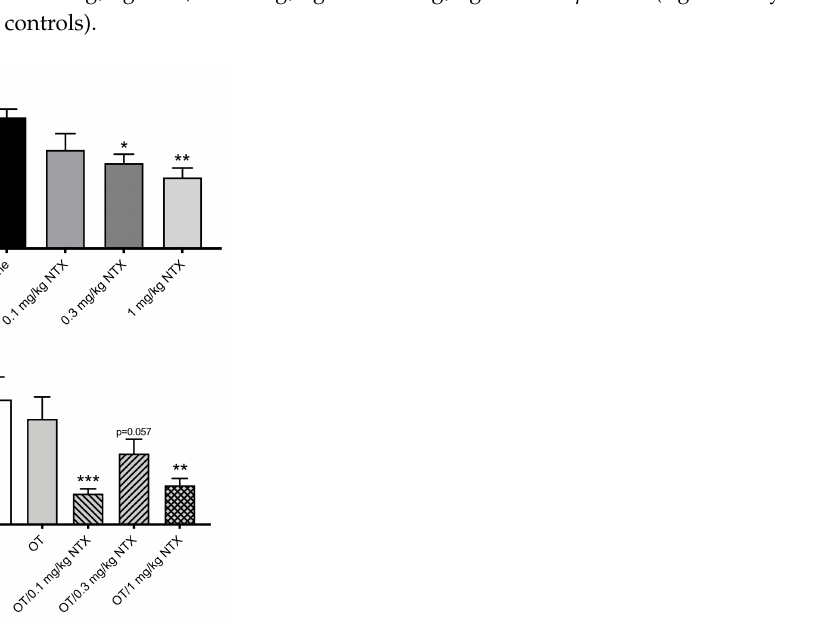
Figure 3. Episodic 2 h 10% sucrose solution diet intake in nondeprived rats injected IP with: ( A ) saline, 0.1 mg/kg NTX, 0.3 mg/kg NTX, or 1 mg/kg NTX; or ( B ) saline, 0.1 mg/kg OT, 0.1 mg/kg OT + 0.1 mg/kg NTX, 0.1 mg/kg OT + 0.3 mg/kg NTX, or 0.1 mg/kg OT + 1 mg/kg NTX. * − p < 0.05; ** − p < 0.01; *** − p < 0.001 (significantly different from saline